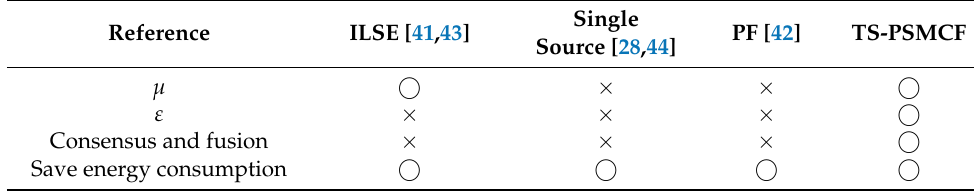
Table 2. Comparison of factors considered in classical tracking algorithms.